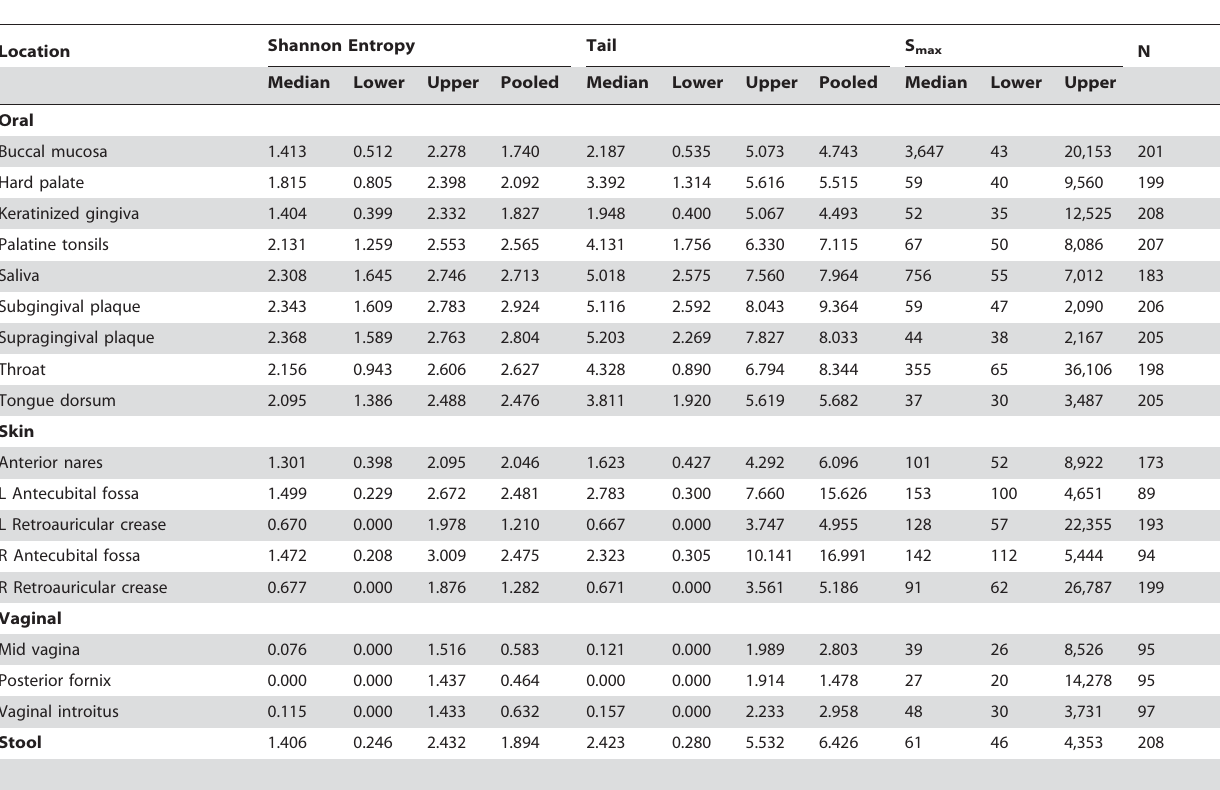
Table 5. Diversity indices computed on ‘‘common’’ genera-based taxonomic units.